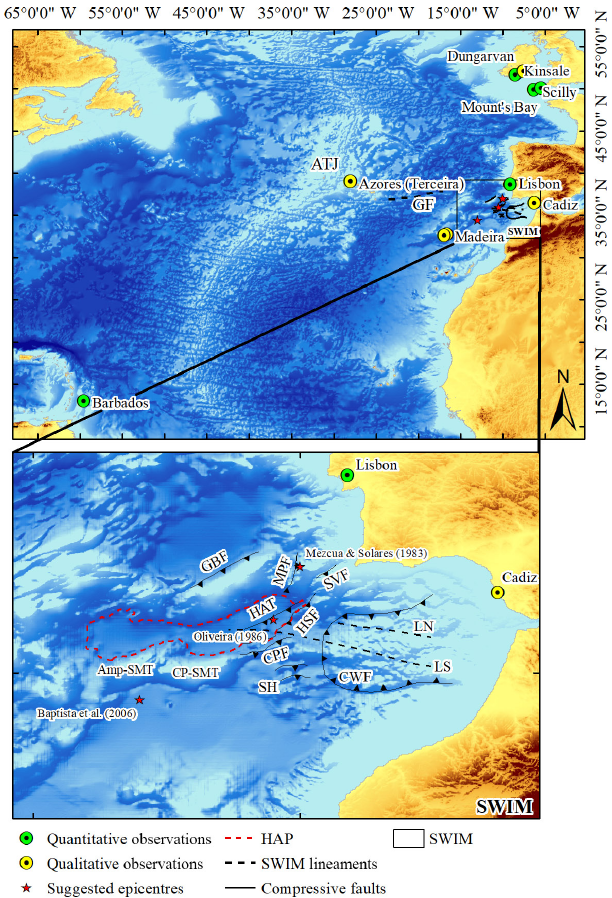
Figure 1. The red stars plot the source location by Oliveira (1986), Mezcua and Solares (1983) and Baptista et al. (2006). The green circles depict the quantitative tsunami observation points, and the yellow circles show the locations of the qualitative descriptions of the tsunami in 1761. The main features of the Azores Gibral- tar fracture zone are the Azores Triple Junction (ATJ), the Gloria Fault (GF) and the Southwest Iberian Margin (SWIM). The inset shows the position of the Ampere seamount (Amp-SMT), the Coral Patch Seamount (CP-SMT) and the locations of the known faults. The black lines mark the faults, and the triangles indicate the di- rection of dip. The dashed black lines trace the main strike-slip faults. The known thrust faults are the Coral Patch Fault (CPF), the Cadiz Wedge Fault (CWF), the Gorringe Bank Fault (GBF), the Horseshoe Fault (HSF), the Marques de Pombal Fault (MPF), the Seine Hills (SH) and the São Vicente Fault (SVF). The shown strike-slip faults are the SWIM lineaments (LN) and (LS) and the Gloria Fault (GF). The dashed red line limits the Horseshoe Abyssal Plain